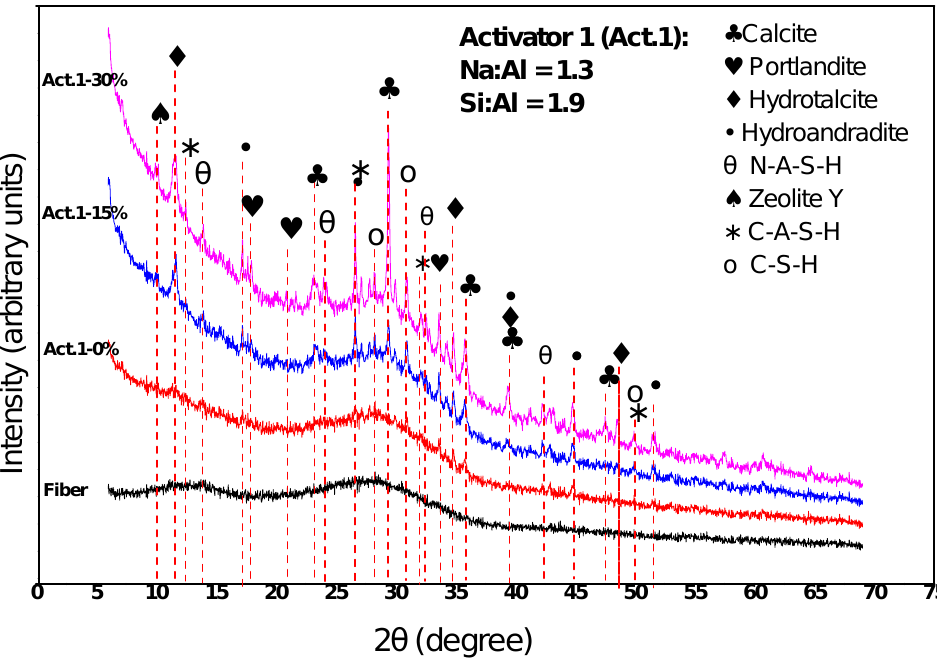
Figure 9. Diffractograms (XRD) of the combinations of alkali-activated cement with Act.1, with- out addition and with the addition of